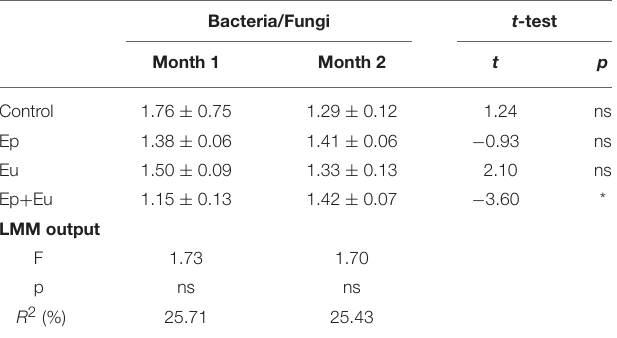
TABLE 2 | Ratio of bacterial to fungal PLFA (mean ± standard deviation) of four experimental treatments 1 and 2 months after Collembola re-inoculation. Bacteria/Fungi t-